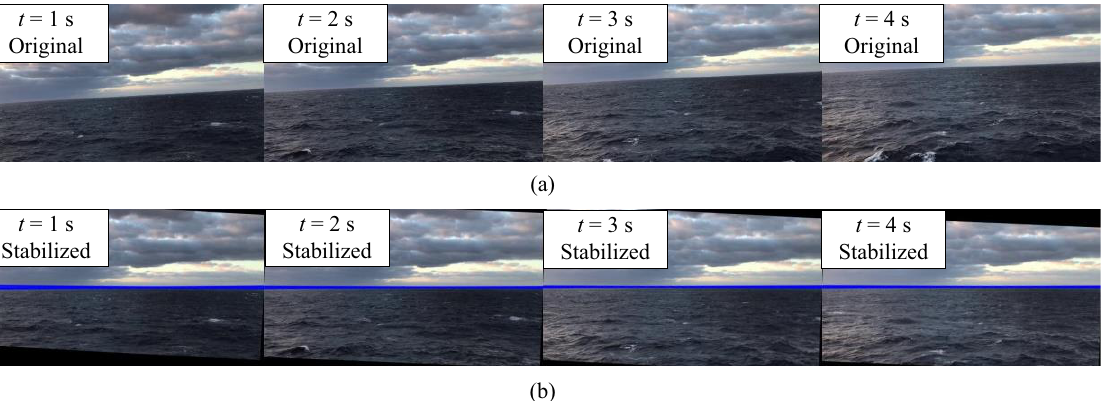
Figure 12. Comparison of the original and stabilized images from the electronic stabilization algo- rithm. ( a ) The original image; ( b ) the stabilized image.